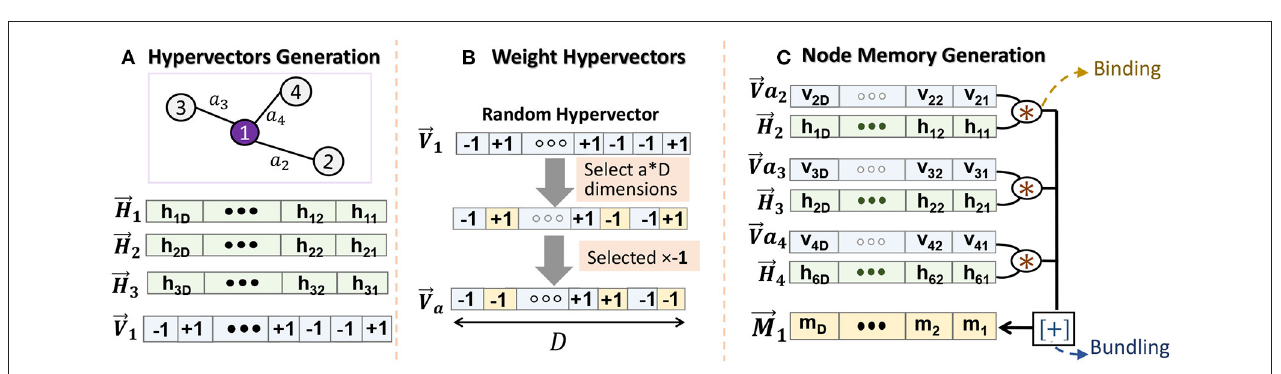
δ ( E V a , E V 1 ) 1 V a as: f ( V a ) + E E 2 = = V a E